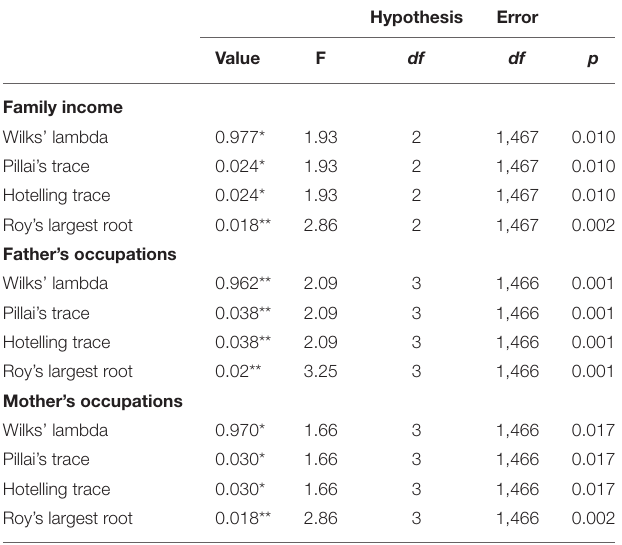
TABLE 2 | Results of MANOVA for dependent variables of COVID-19 awareness, knowledge and preparedness.